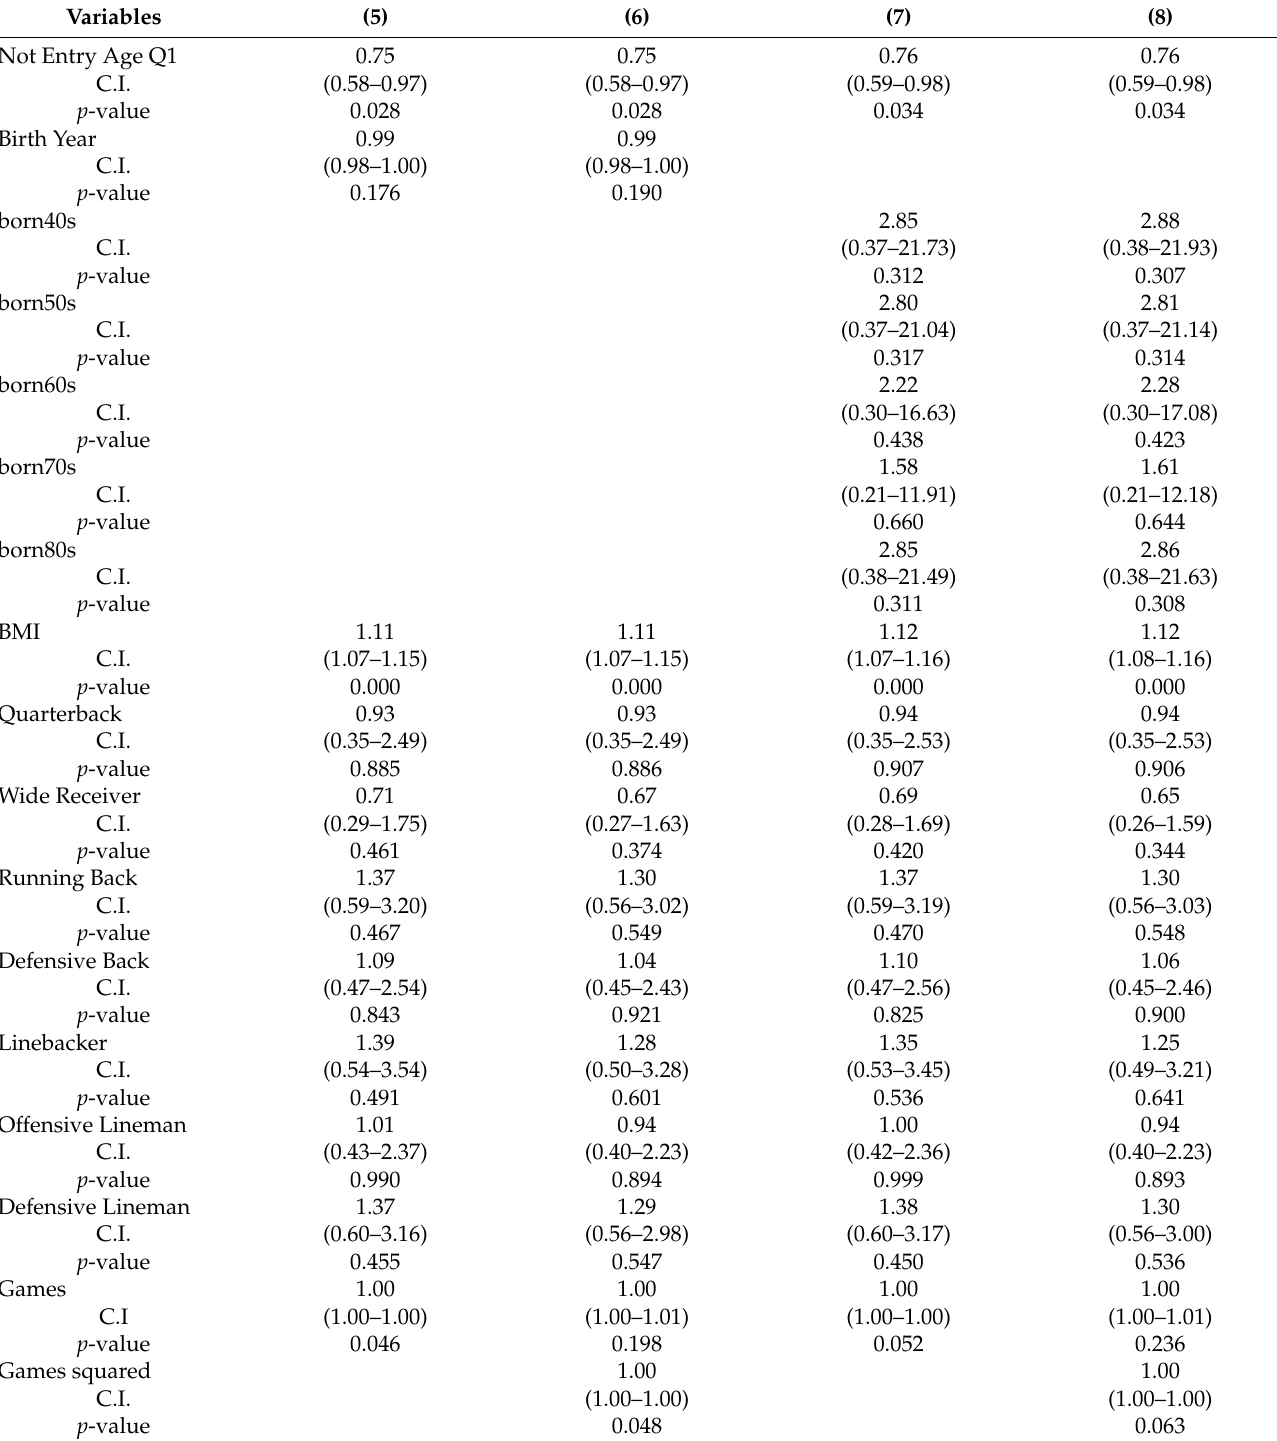
Table 3. Cox Regression Results with Not NFL Entry Age Q1